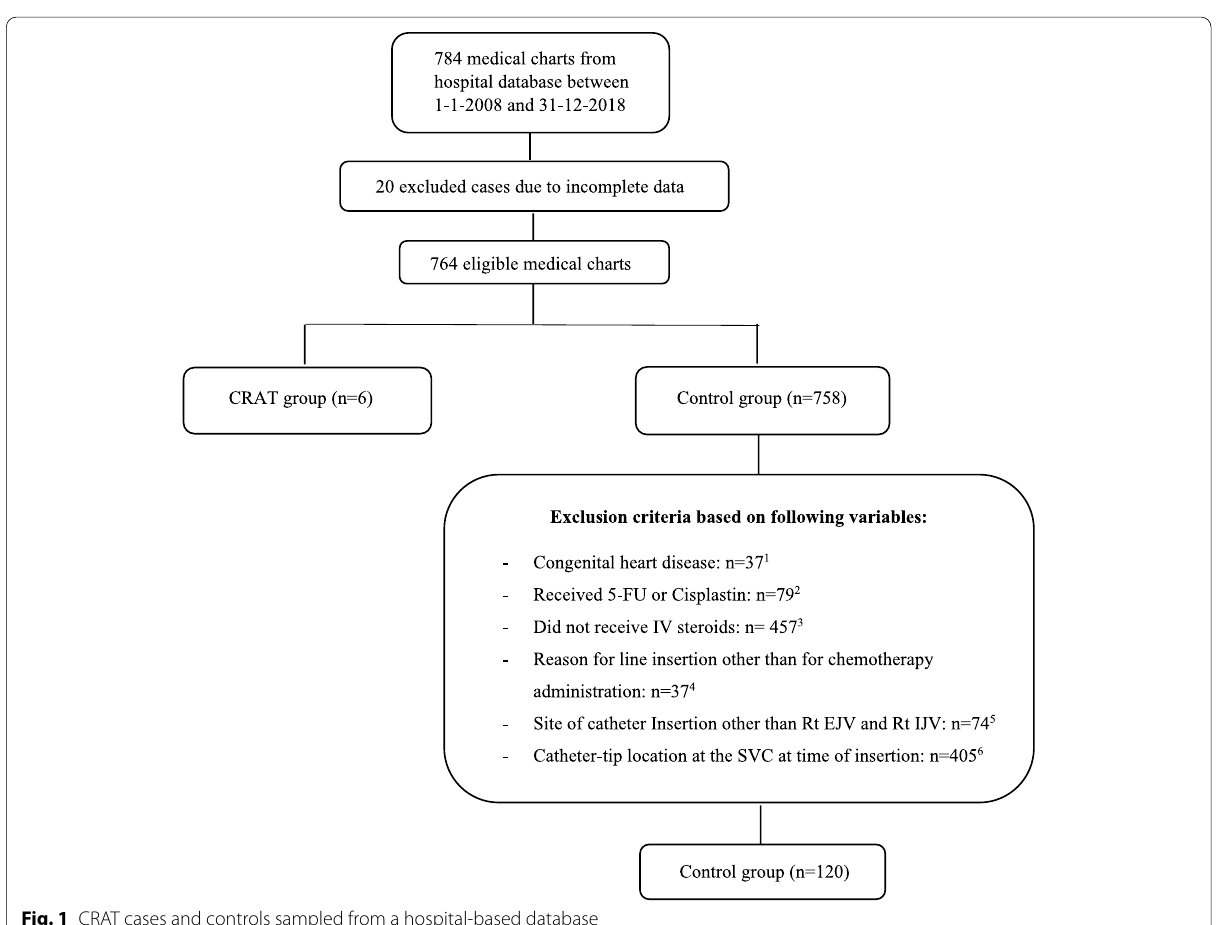
Fig. 1 CRAT cases and controls sampled from a hospital‑based